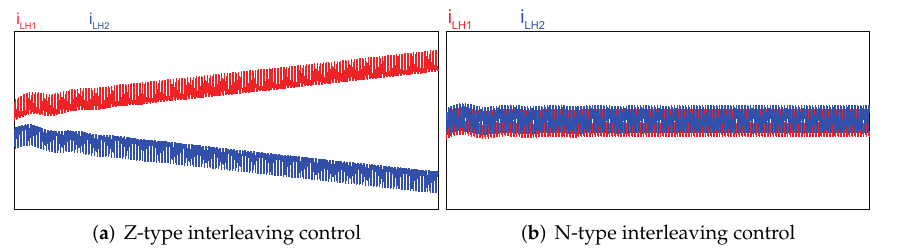
Figure 12. Current response in two modules for open loop